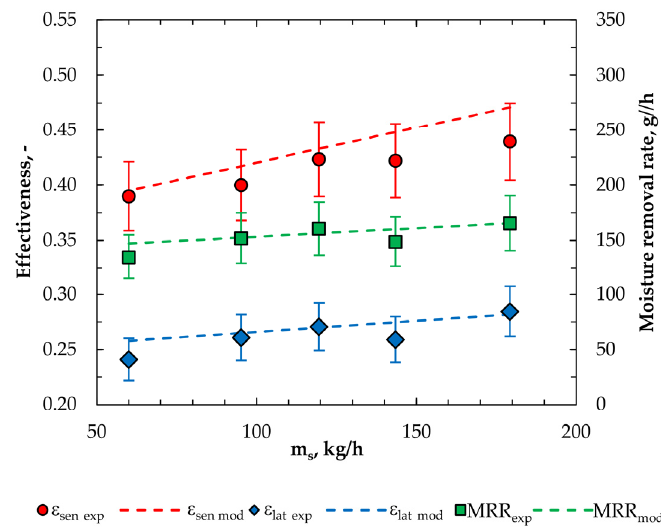
Figure 5. Comparison of experimental and modeling performance indices of the module for solution flow rate (m a = 117 kg/h, X = 32.0%).